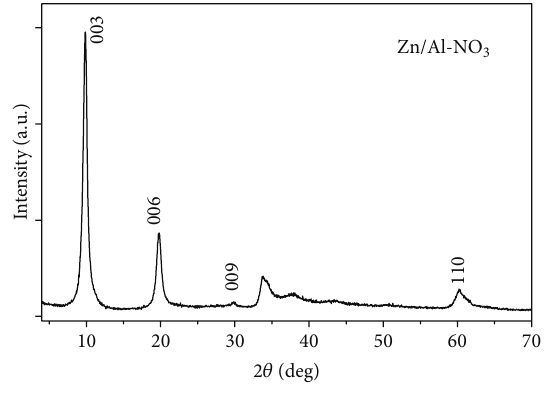
Figure 1: XRD patterns of Zn/Al-NO 3